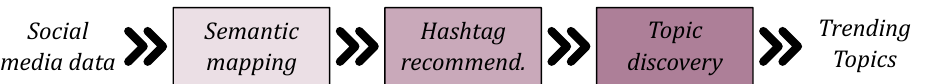
Figure 3. Execution flow of HAshtag recommendation using Sentence-to-Hashtag Embedding Translation